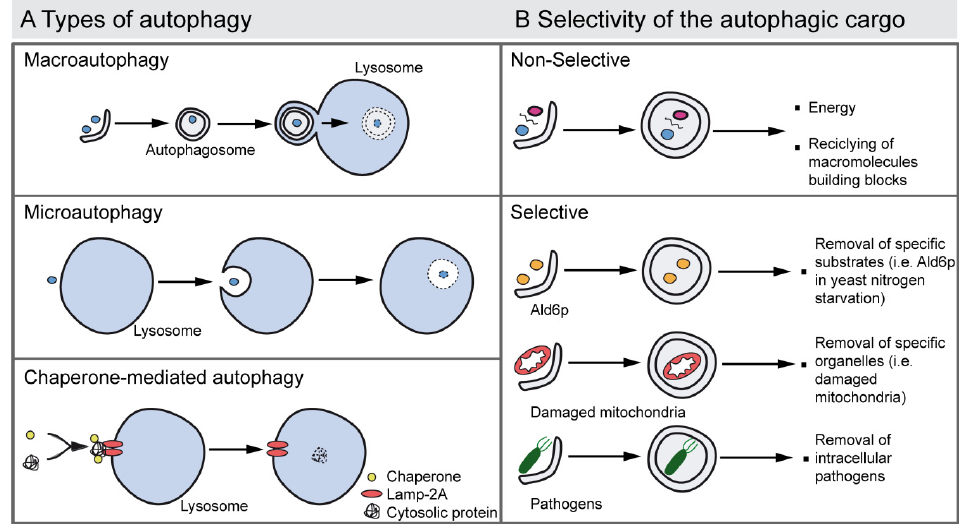
Figure 2. Autophagy types, cargo selectivity and the process of autophagosome formation. ( A ) The drawing shows the major types of autophagy. Macroautophagy involves the sequestration of cytosol and organelles by the autophagosome, a double membrane vacuole; the autophagosome then fuses with a lysosome and acid hydrolases degrade its contents. The process of microautophagy implicates the degradation of cytoplasmic material that is directly invaginated by the lysosome. Chaperone-mediated autophagy entails the degrada (cid:87)(cid:76)(cid:82)(cid:81)(cid:3) (cid:82)(cid:73)(cid:3) (cid:86)(cid:83)(cid:72)(cid:70)(cid:76)(cid:191)(cid:70)(cid:3) (cid:70)(cid:92)(cid:87)(cid:82)(cid:86)(cid:82)(cid:79)(cid:76)(cid:70)(cid:3) (cid:83)(cid:85)(cid:82)(cid:87)(cid:72)(cid:76)(cid:81)(cid:86)(cid:3) (cid:87)(cid:75)(cid:68)(cid:87)(cid:3) (cid:69)(cid:76)(cid:81)(cid:71)(cid:3) (cid:87)(cid:82)(cid:3) (cid:70)(cid:75)(cid:68)(cid:83)(cid:72)(cid:85)(cid:82)(cid:81)(cid:72)(cid:86)(cid:3) (cid:68)(cid:81)(cid:71)(cid:3) (cid:87)(cid:75)(cid:72)(cid:3) complex joins to the lysosomal receptor Lamp-2A receptor triggering the translocation to the lumen. ( B ) Autophagy degrades selective and non-selective cargo. Autophagy may non-selectively digest fragments of cytoplasm to renovate the cellular components, or to obtain energy and free macromolecules to proceed with synthesis de novo . Autophagy also shows cargo selectivity degrading: (i) Specific molecules such as the elimination of the yeast Ald6p, which is negative for survival under nitrogen starvation, (ii) damaged organelles such as mitochondria with impaired membrane potential (this process is also known as mitophagy), and (iii) intracellular pathogens where it contributes to elimination of these. Selective autophagy is usually mediated by adapter proteins such as the p62 receptor and NBR1, which also function as cargo receptors in the elimination of ubiquitinated substrates. ( C ) The drawing represents a simplified overview of the factors and processes required in autophagosome formation. Growth factor deprivation or nutrient starvation regulates the translocation of the ULK1 complex to the endoplasmic reticulum and activates the phosphatidylinositol 3-kinase complex III (PI3KCIII) that promotes the nucleation of the phagophore that sequesters the cytosolic material. Atg9 is also involved in the phagophore nucleation step. Autophagosome elongation and completion is triggered by the Atg12 (cid:177) Atg5 (cid:177) Atg16 and by LC3, a homologue of the yeast Atg8 that is proteolysed into the LC3-II form and conjugates with phosphatidylethanolamine. This protein-lipid complex forms part of the double-membrane